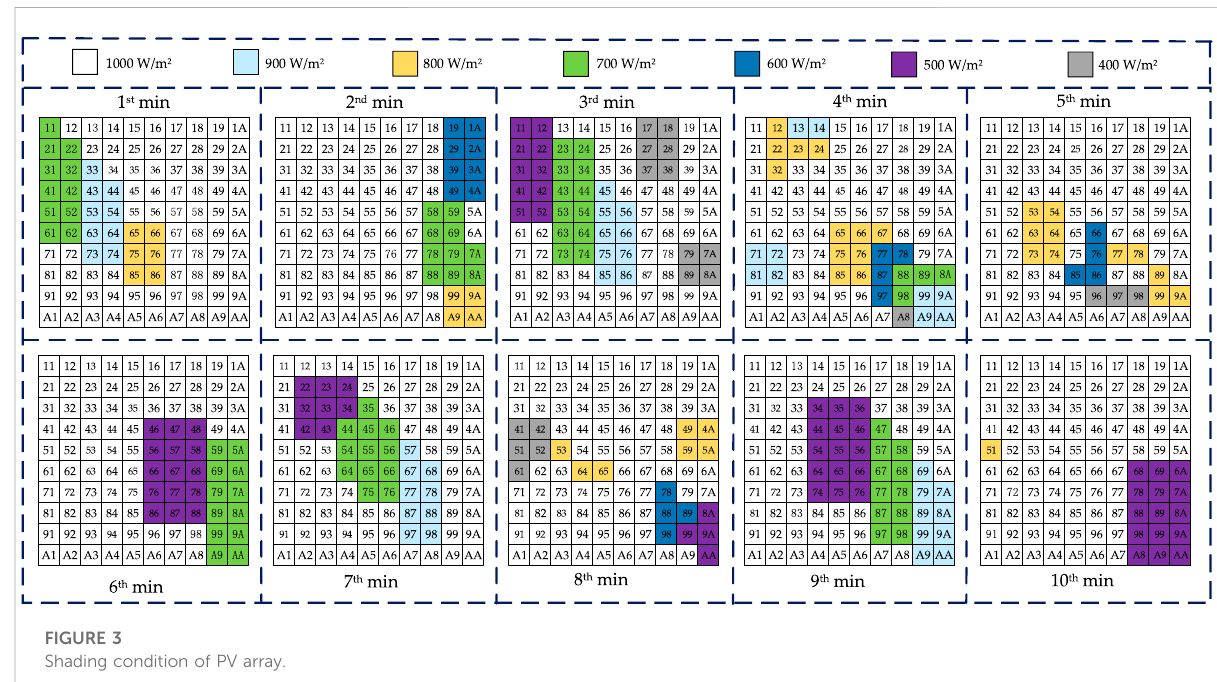
FIGURE 3 Shading condition of PV